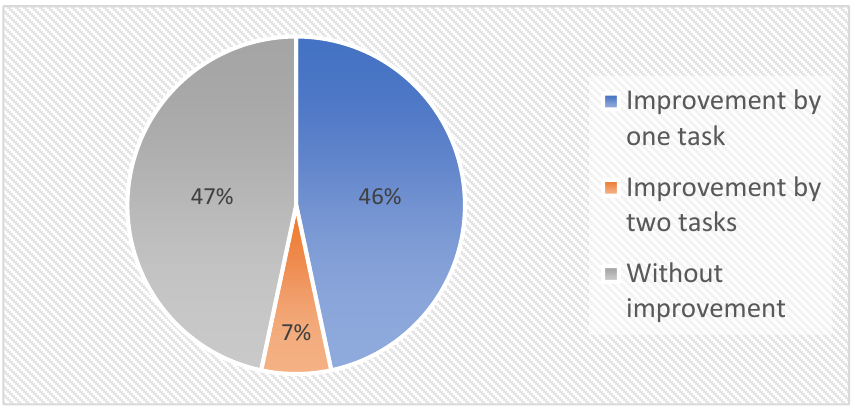
Figure 16. Students who were able to improve their performance in completing tasks.